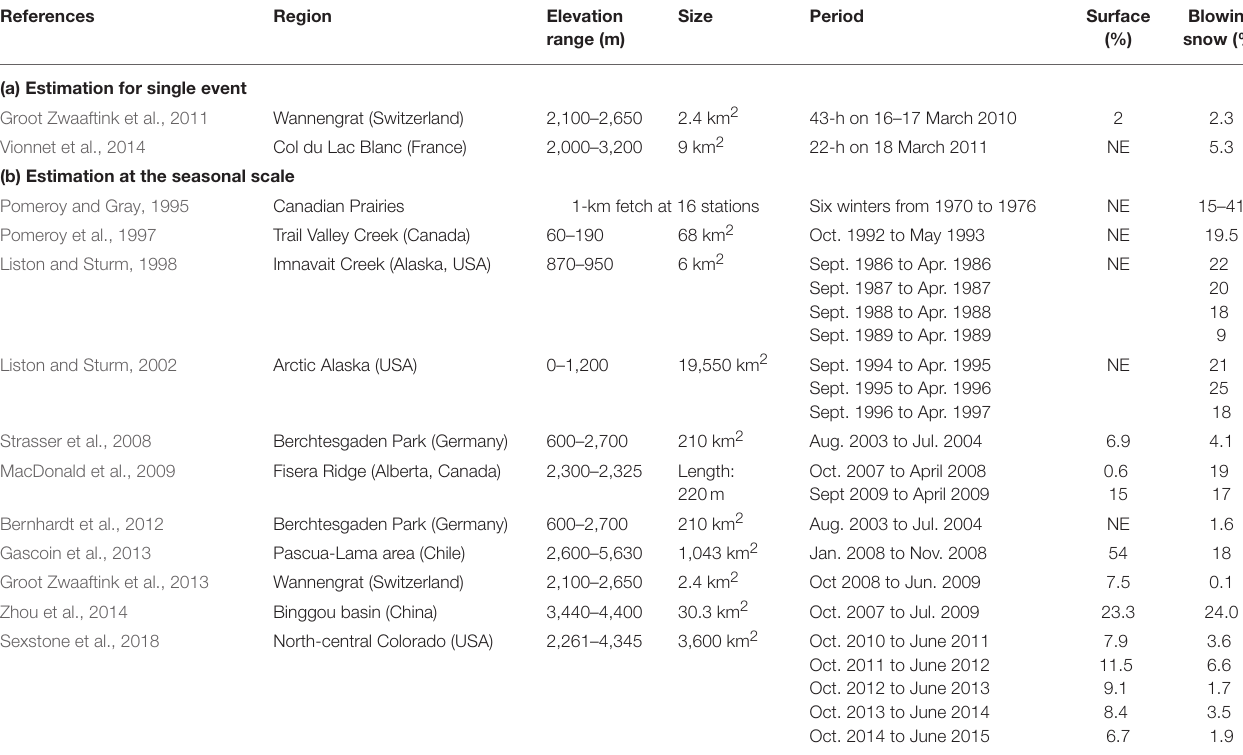
TABLE 1 | Estimation of mass loss due to surface and blowing snow sublimation for (a) single events and (b) at the seasonal scale reported in different studies.